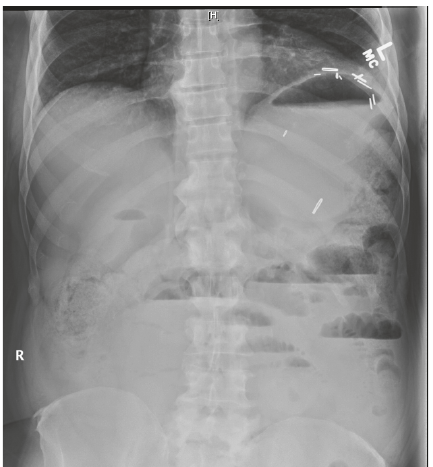
Figure 1: Abdominal X-ray showing scattered air-fluid levels in minimally prominent small bowel loops (case 1).